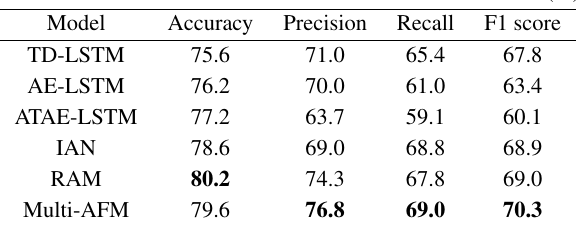
Performance comparison of each model on Restaurant dataset.